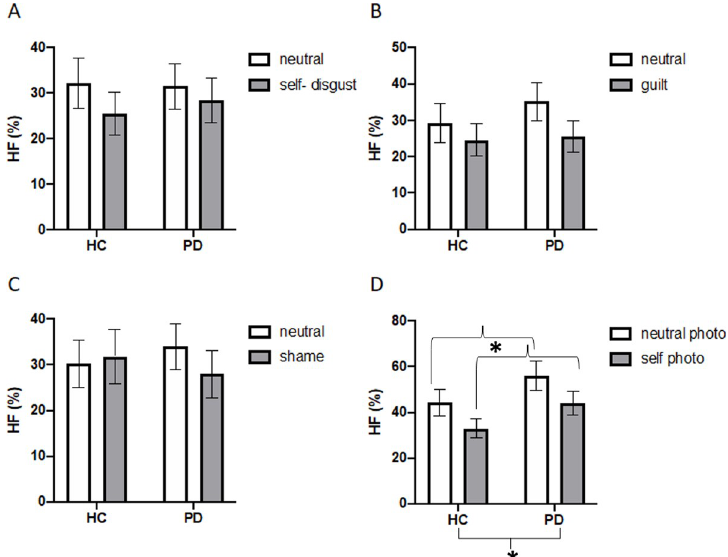
Fig 3. Percentage of high frequency band heart rate variability (HF) as a function of condition (emotion and neutral) and group (HC = Healthy Controls and PD = Parkinson’s Disease patients). Panels A-C: Physiological responses for self-disgust, guilt and shame narration paradigms, respectively. Panel D: Physiological responses for the photo paradigm (self-disgust induction). Error bars represent standard error and asterisk significant differences (p <